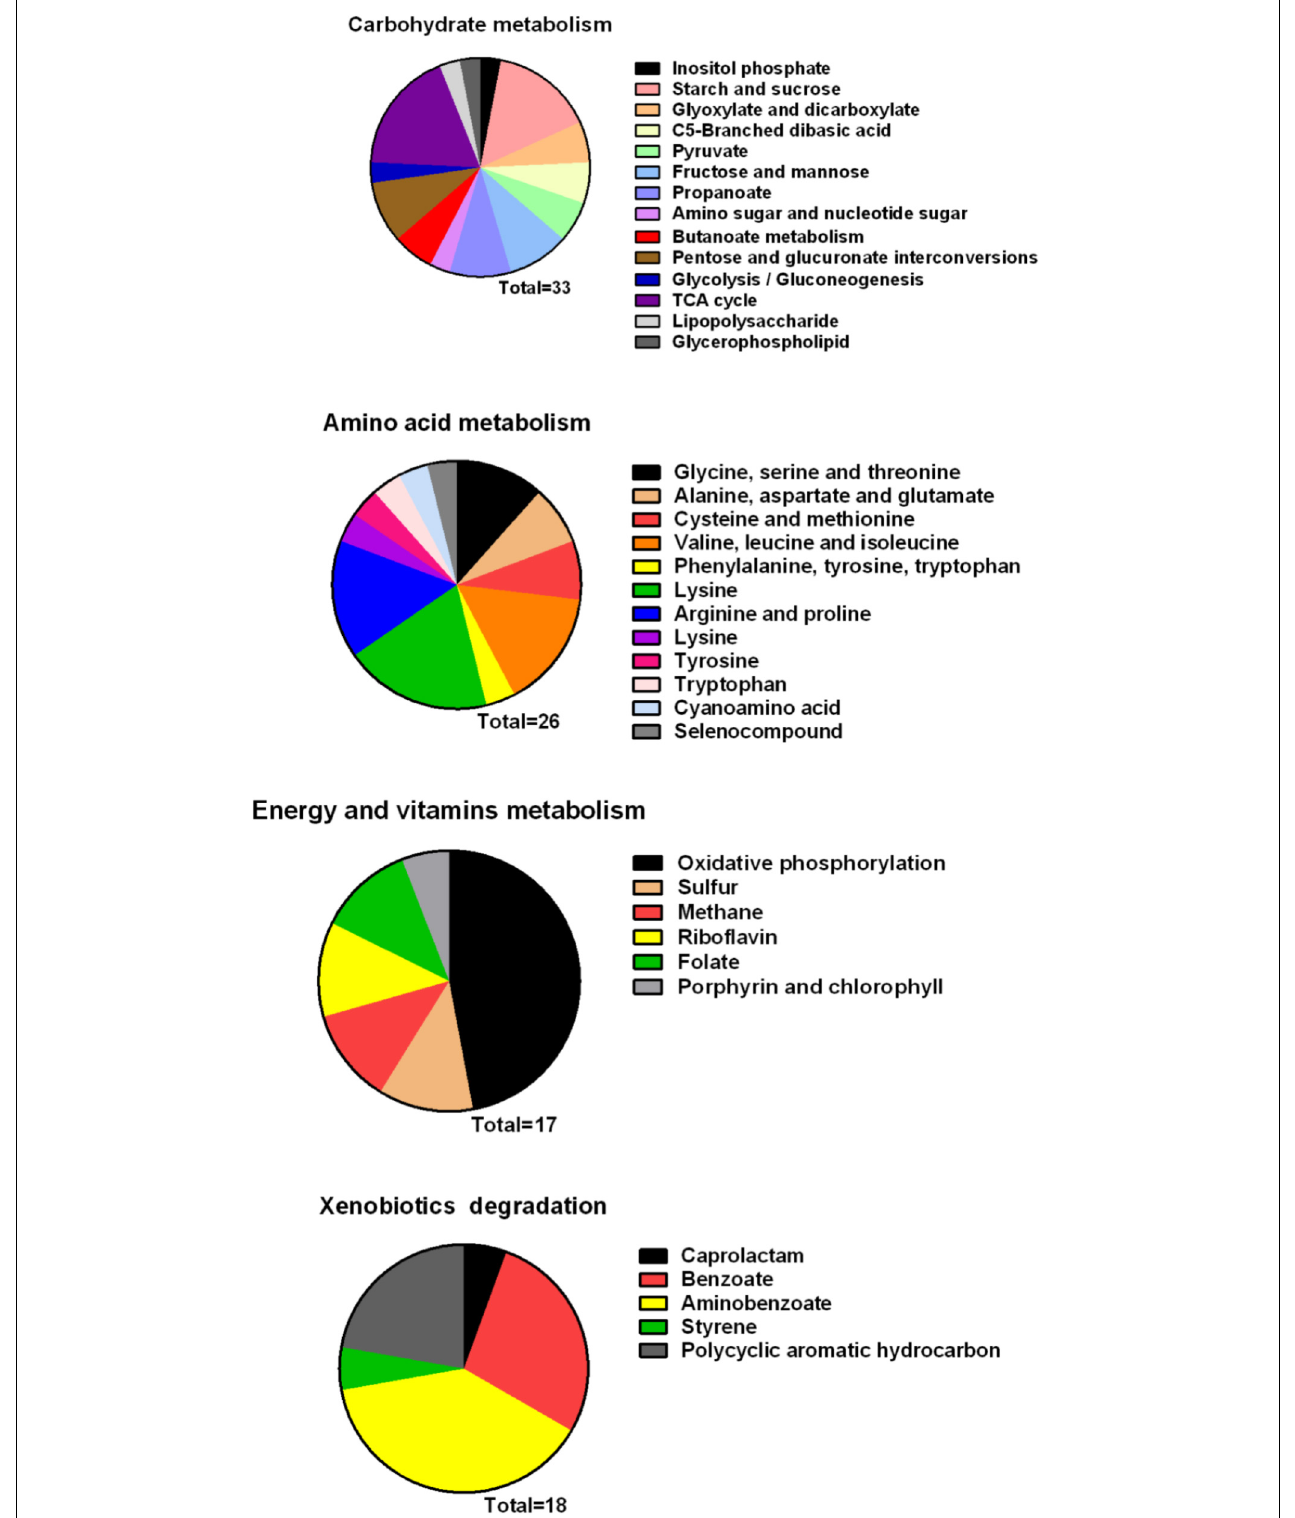
FIGURE 8 | Classification of differential genes in the metabolism in PXO99 under melatonin treatment.